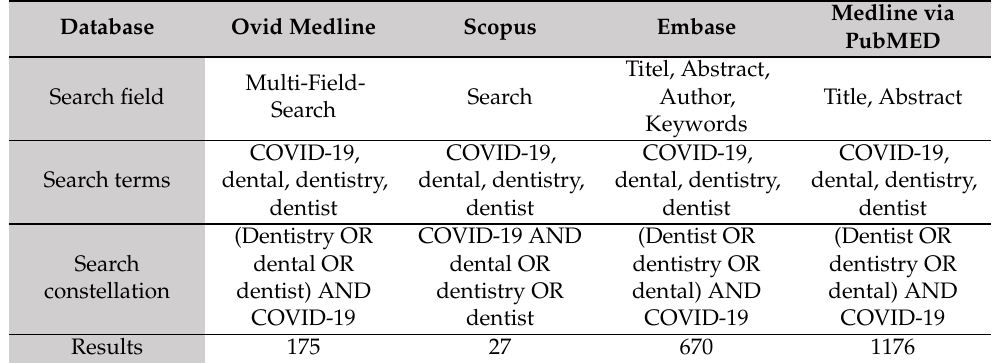
Table 1. Database search